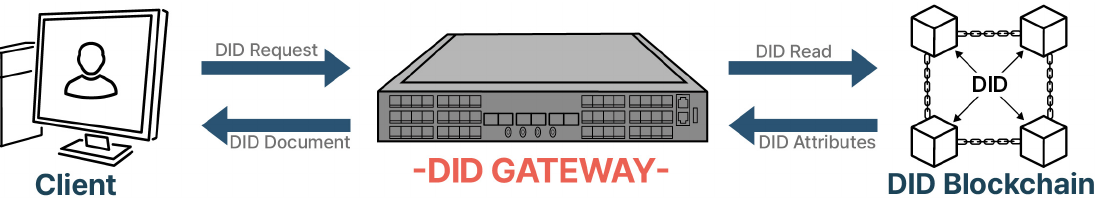
Figure 3. DID authentication network.